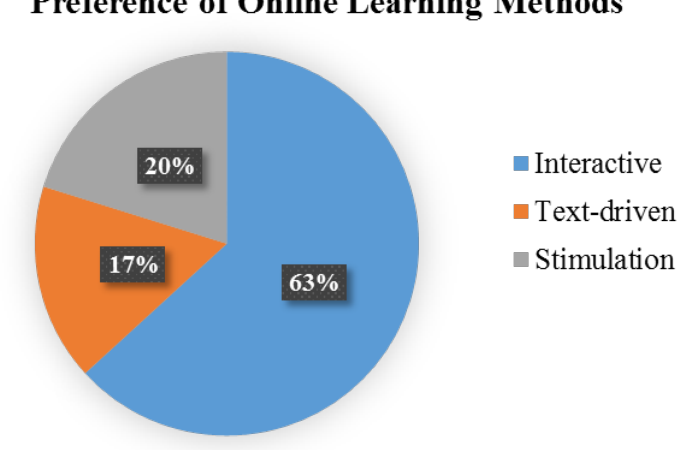
Figure - 12: Showing preference of online learning